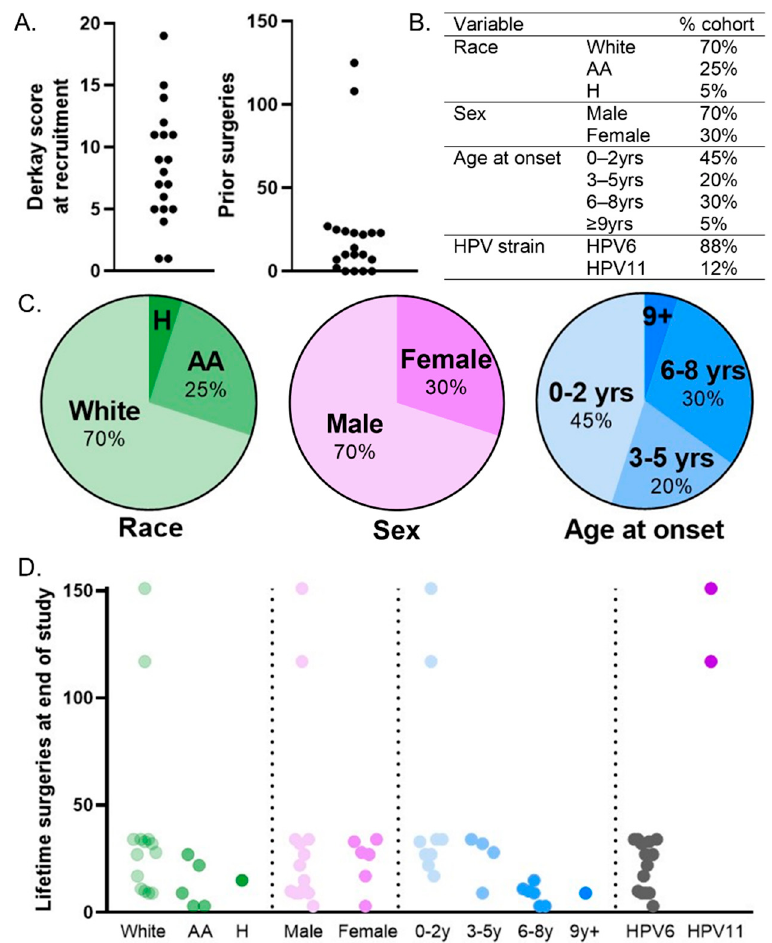
Figure 1. Clinical and demographical characteristics of the recruited JoRRP cohort. ( A ) At the time of recruitment, measures of disease severity across 20 patients in the cohort showed an average Derkay score of 8.0 (range 0–19) and 23 previous surgeries (range 0–125). ( B ) Summary of demographical characteristics of the cohort from Table 2. ( C ) Patient characteristic summary graphs indicating that patients were predominately white and male and had an early ( ≤ 5 yrs) age at disease onset. ( D ) The number of lifetime surgeries at the end of the study is broken down by demographical sub-categories. H = Hispanic, AA = African American.